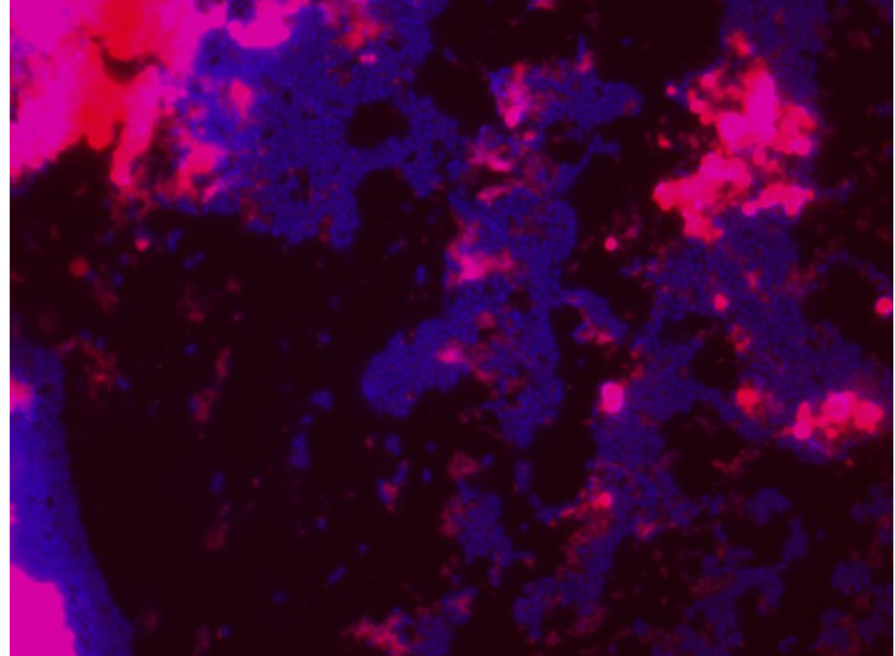
Figure 8. Pseudomonas fluorescens biofilm (7 days) on the stainless steel. Coupons stained with DAPI (0.1 mg/mL; 10 µ L) and Rhodamine B (0.1 mg/mL; 10 µ L) (Magnification × 100).